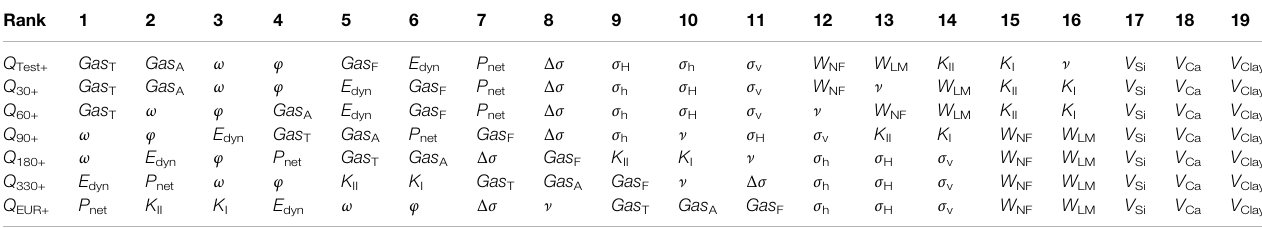
TABLE 3 | Correlation ranking of each in fl uencing factor to production dynamic monitoring target.